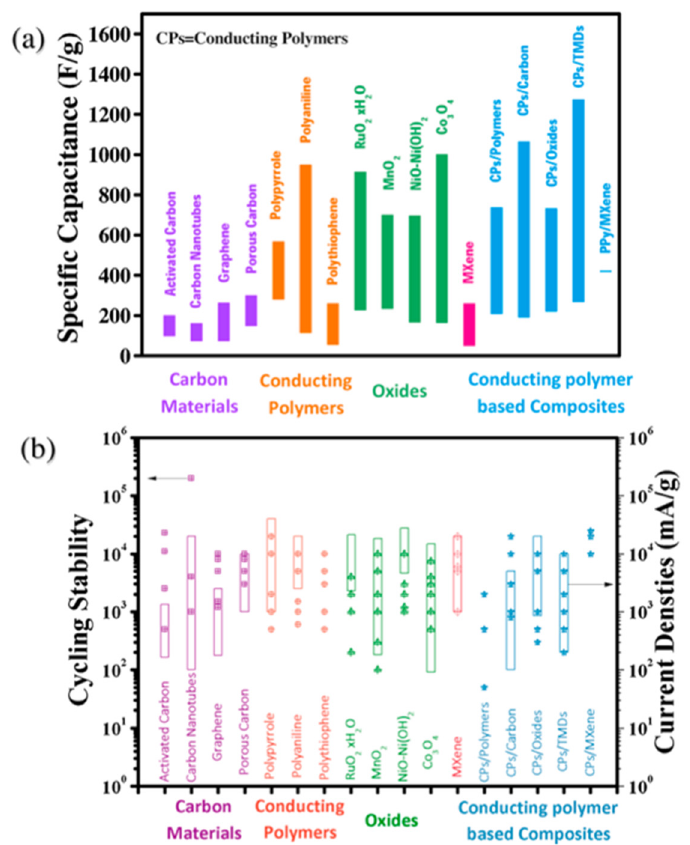
Figure 2. Comparison of ( a ) specific capacitance and ( b ) cycling stability and current density range for typical electrode materials for supercapacitor applications [37]. Reproduced with permission from ref. [37].